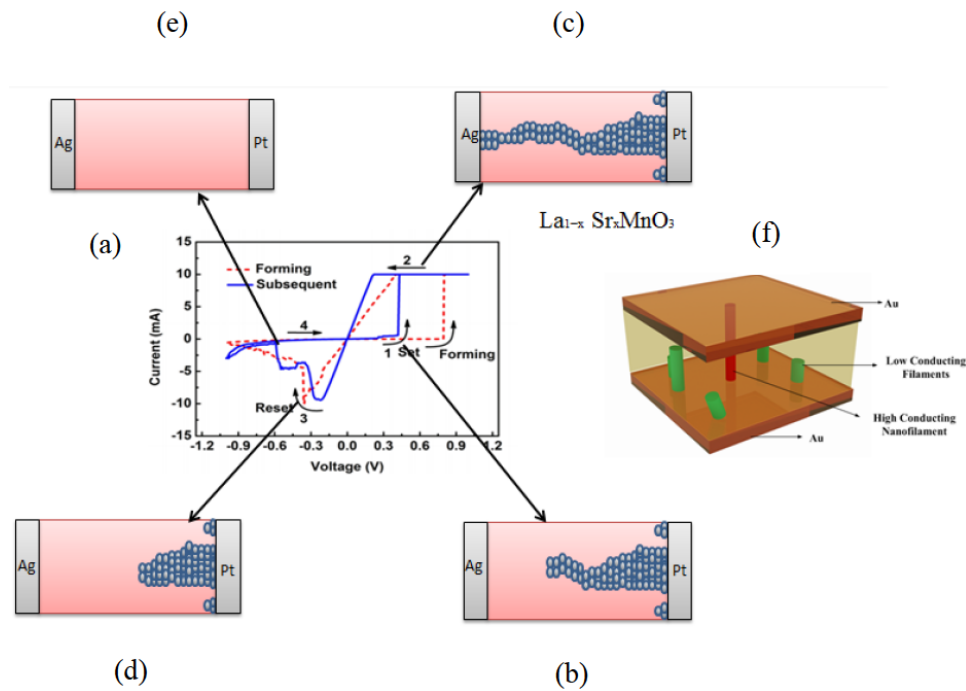
Figure 2: (a) Pinched hysteresis loop of Ag/a-LSMO/Pt memristor (b)Region 1 indicating the initiation of the growth of Ag filament from the bottom inert platinum electrode to the top non inert (Ag) electrode, (c) In region 2 device is in LRS as the conducting filament connects both top and bottom electrode,(d)region 3 corresponds to the beginning of process of RESET as conducting filament gradually starts obliterating (e) Device is in HRS as conducting filament completely obliterated. Reprinted with permission from D. Liu, H. Cheng, X. Zhu, G. Wang and N. Wang // ACS Appl.Mater. Interfaces 5 (2013)11258, (C) 2013 American Chemical